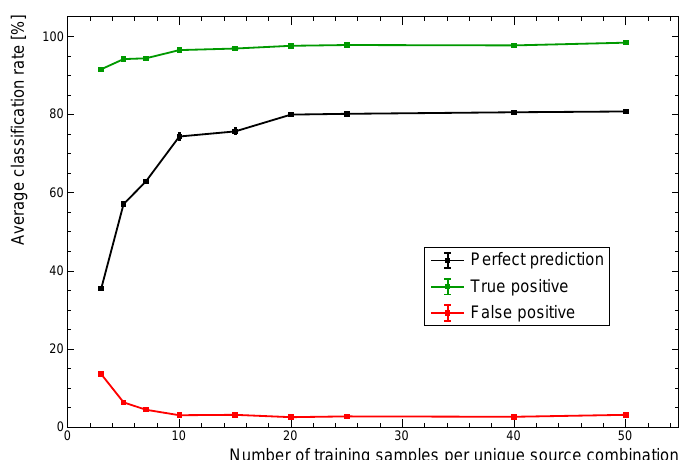
Figure 8. Comparison of performance with number of training samples. While there is a sharp rise in performance as more training spectra are added, the performance plateaus for these particular data. For more complex data sets, additional training samples are expected to become far more